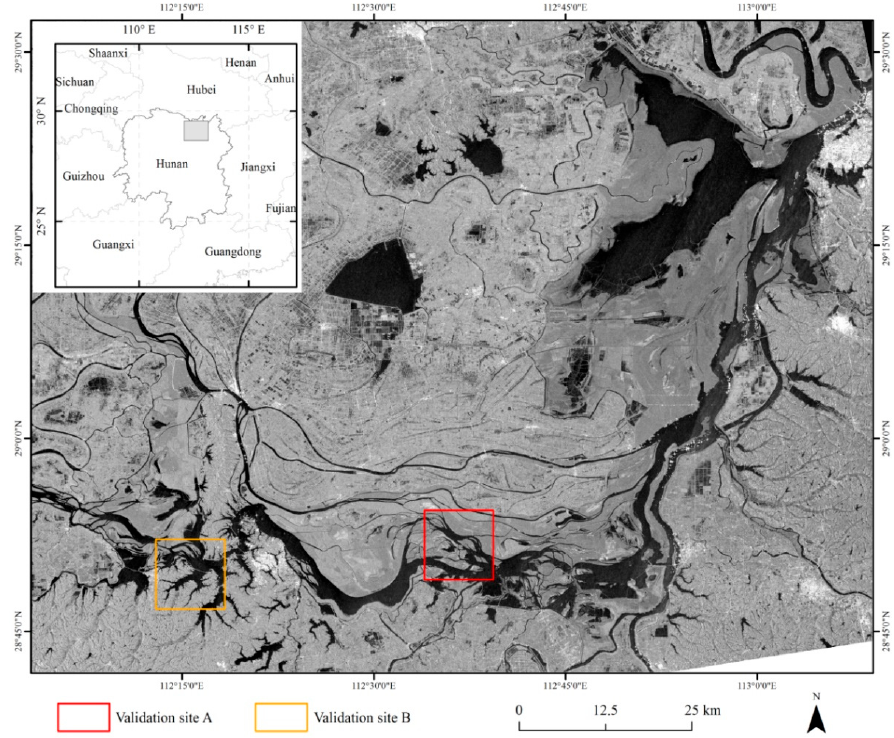
Figure 1. Dongting Lake plain (China) and two test sites. The Sentinel-1 scene with vertically transmitted vertically received (VV) polarization acquired on 23 May 2017.